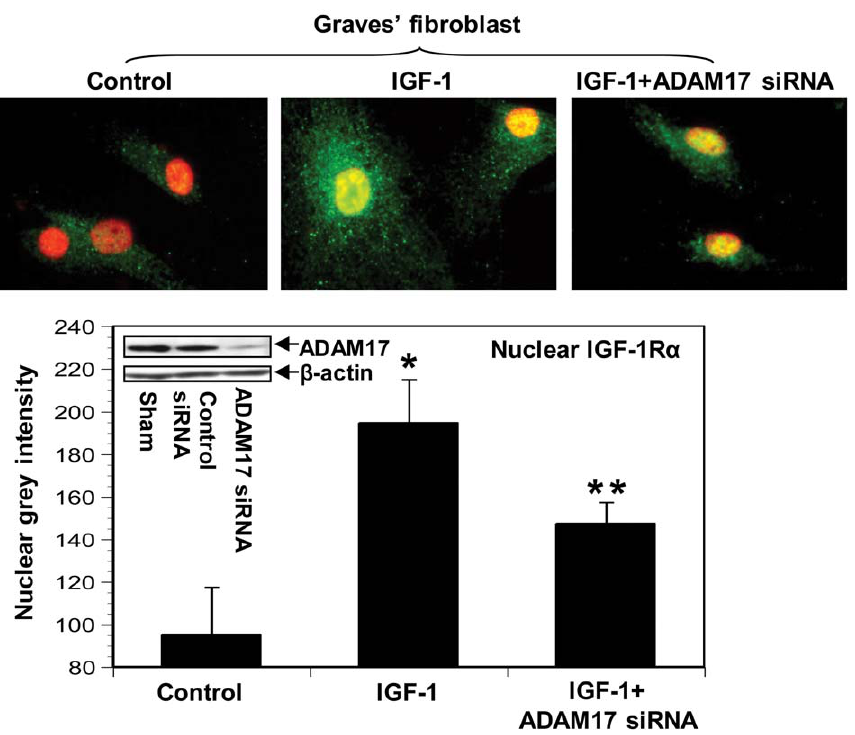
Figure 5. siRNA directed against ADAM17 attenuates the nuclear accumulation of IGF-1R a in GD orbital fibroblasts. Fibroblasts were transfected with control siRNA or that specifically targeting ADAM 17. Some were left untreated while others were treated with IGF-1. Cells were fixed and stained with anti-IGF-1R a Ab/Orgeon Green anti-rabbit Ab. Quantification of nuclear intensity was conducted so that each column represents the mean of ten randomly chosen nuclei 6 SD. *, p , 0.002 vs control; **, p , 0.01 vs IGF-1. n=3 independent determinations. (Inset) Adam17 siRNA or control siRNA was transfected into GD fibroblasts, cells were lysed, and proteins subjected to Western blot analysis by probing with anti-ADAM 17 Ab, stripping the membrane and incubating with anti- b -actin.